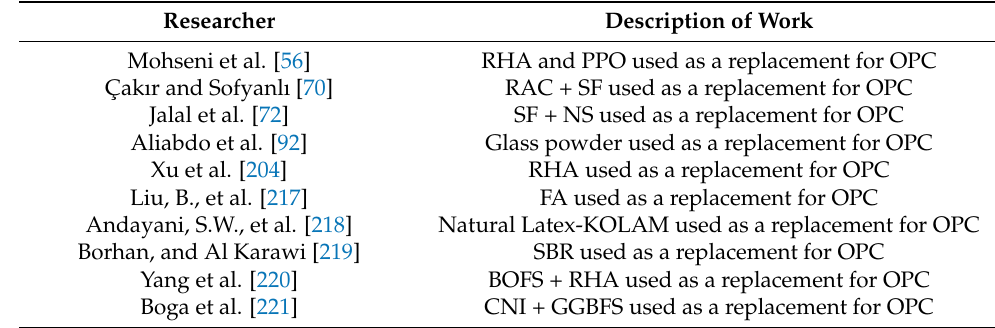
Table 1. Materials (Binders) utilized in different polymer